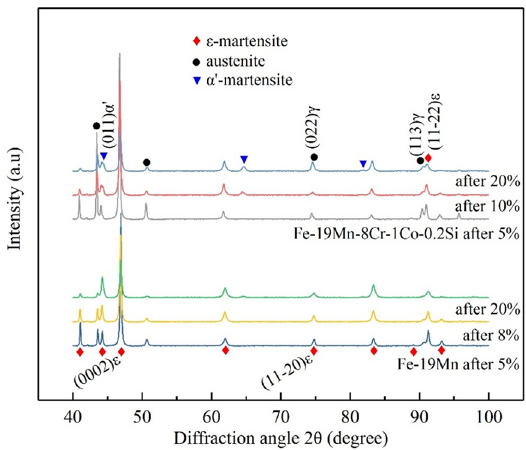
Figure 5. XRD patterns of the Fe-19Mn and Fe-19Mn-8Cr-1Co- 0.2Si alloys after cold rolling. orientation of deformation-induced ε-martensite is mainly controlled by cold rolling direction. Customarily, all Shockley partial dislocations of <211> glide directions on {111} habit planes are responsible for the γ to ε transformation, however, the preferred glide direction occurs and it is activated to complete the transformation during cold rolling. Fig. 7 provides the TEM micrographs and SAEDPs of the Fe-19Mn-8Cr-1Co-0.2Si alloy after 20% cold-rolled deformation, therein Figs. 7e, 7f and 7g represent the SAEDPs corresponding with region A, B and C, respectively. As shown in Fig. 7e, the SAEDP indicates that the orientation relationship between γ-austenite and ε-martensite still obeys the S-N type. The ε-martensite is closely intertwined with the γ-austenite after deformation and high-density dislocations are observed in the bright-field image shown in Fig. 7a. In addition, the SAEDP shown in Fig. 7f reveals the occurrence of the γ-austenite mechanical twins. But as